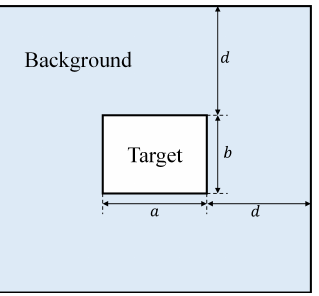
Figure 7. Illustration of target area and its nearby background